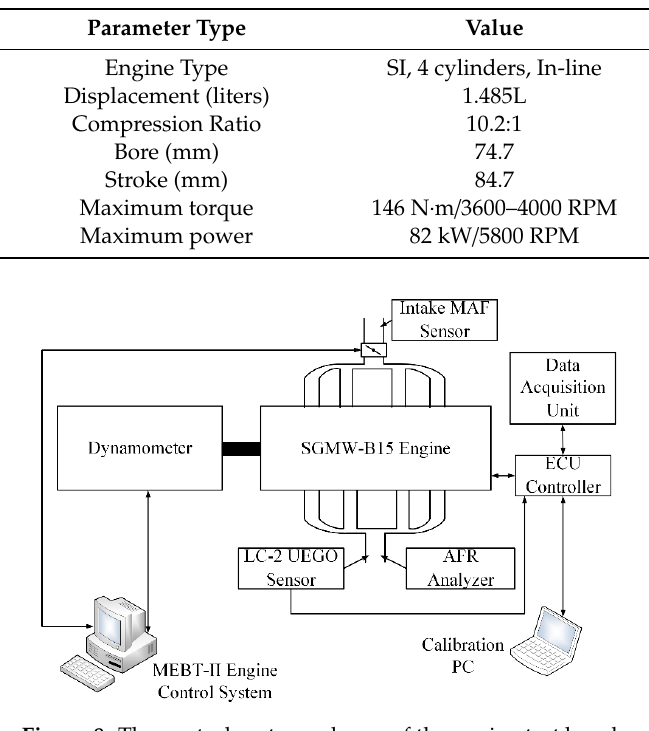
Figure 8. The control system scheme of the engine test bench.